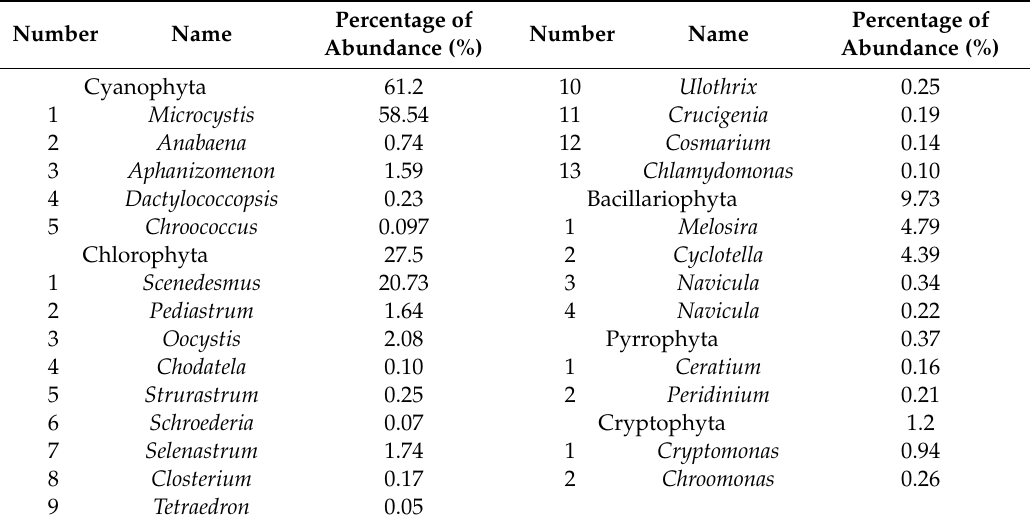
Table 1. The list of the main algal taxon with the percentage of abundance in Dianchi